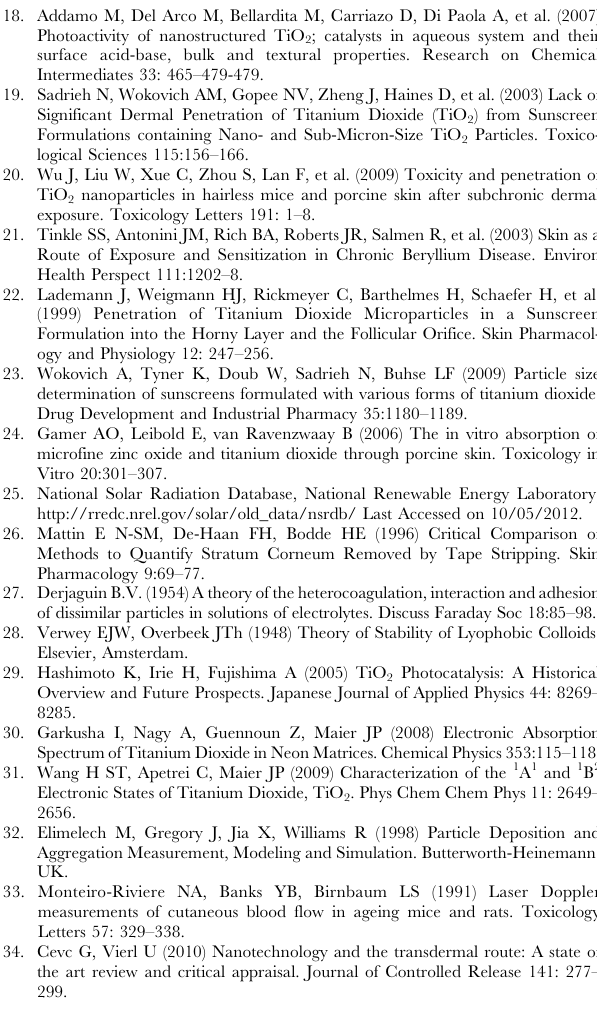
Figure S1 Transmission electron micrographs of TiO 2 used for our work. Micrograph courtesy of Ivy Ji at UCLA. Figure S2 Spectrum of the Xenon arc lamp. Figure S3 Representative volume and intensity distribution results for a 100 mg L-1 TiO 2 solution before and after